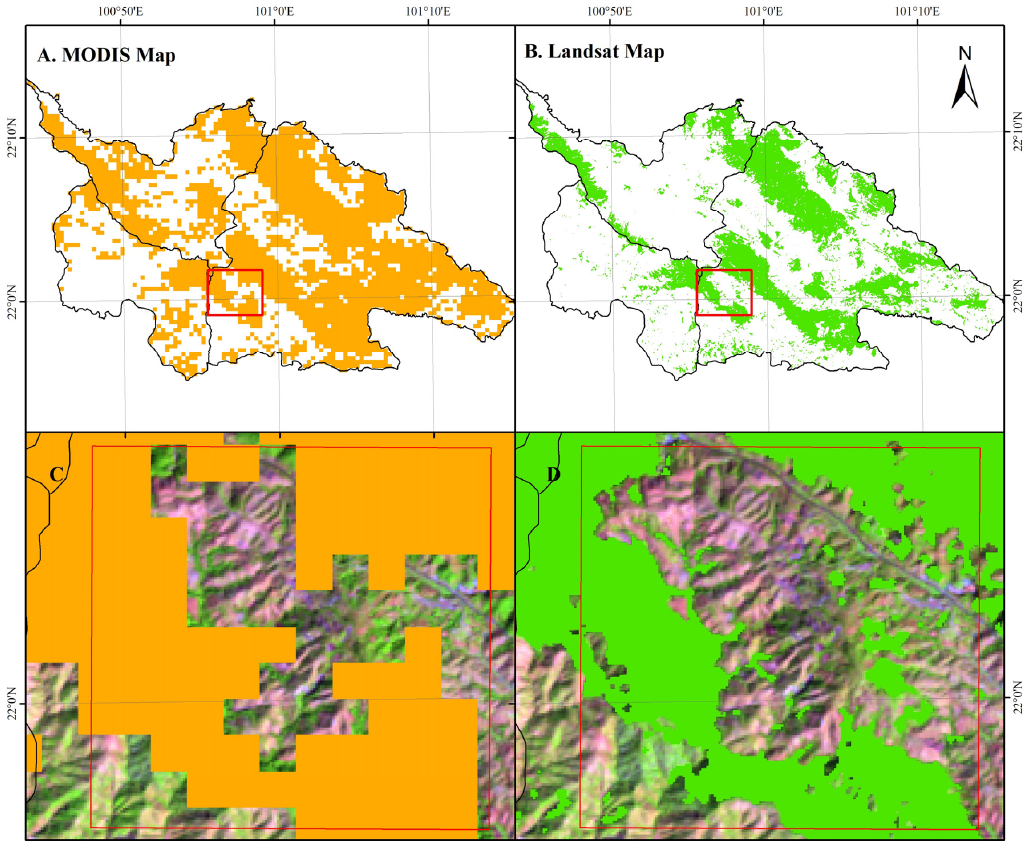
Figure 7. Comparison of eight-day 500-m MODIS MCD12Q1 ( A ) and the 30-m Landsat resultant map ( B ) in 2010. The two zoom-out windows below display the detailed information of MODIS MCD12Q1 ( C ) and the resultant map of 30-m Landsat 5 TM ( D ).